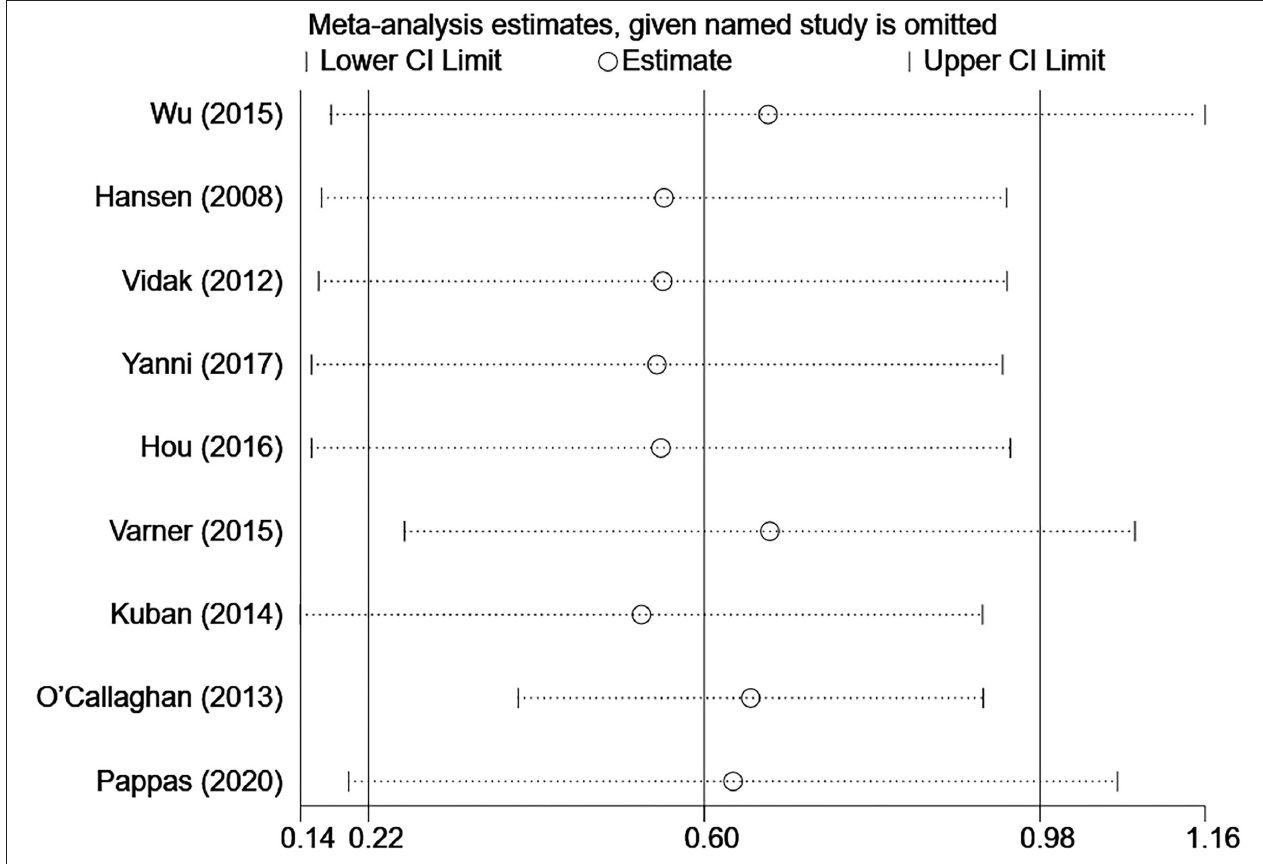
FIGURE 3 | Sensitivity analysis for individual studies on the summary